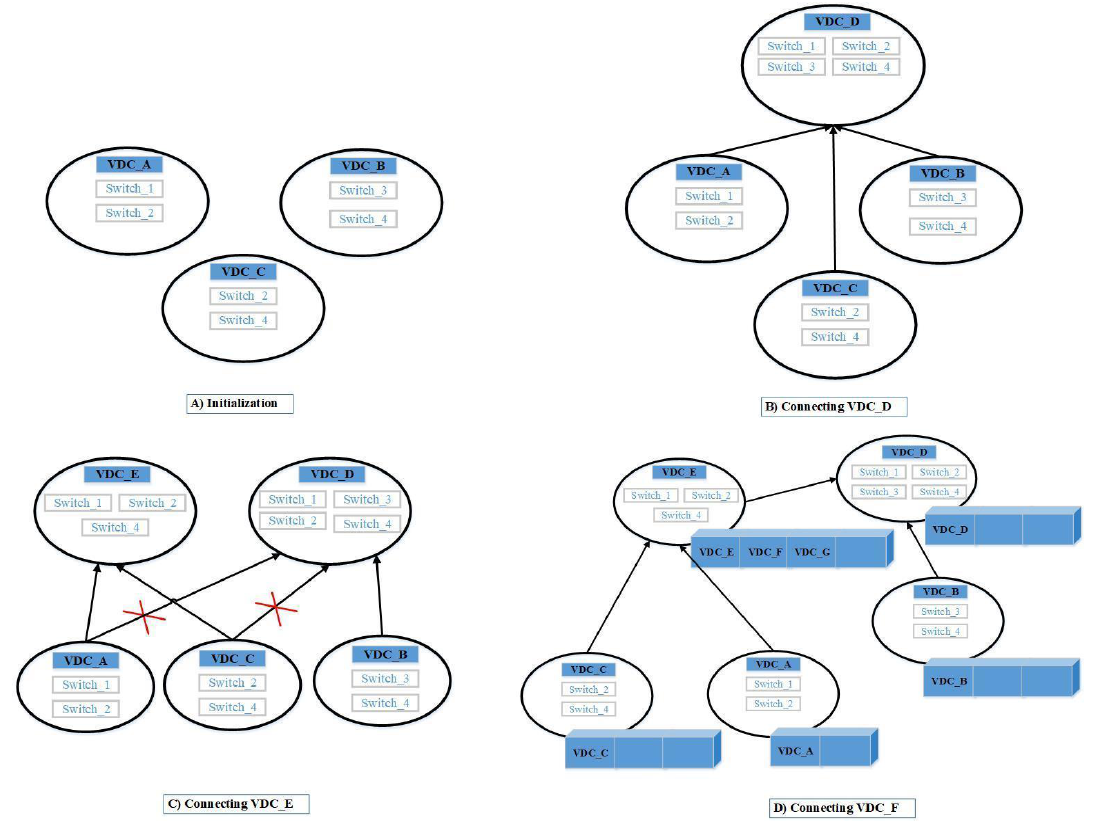
Figure 6. GVMG Mechanism example.